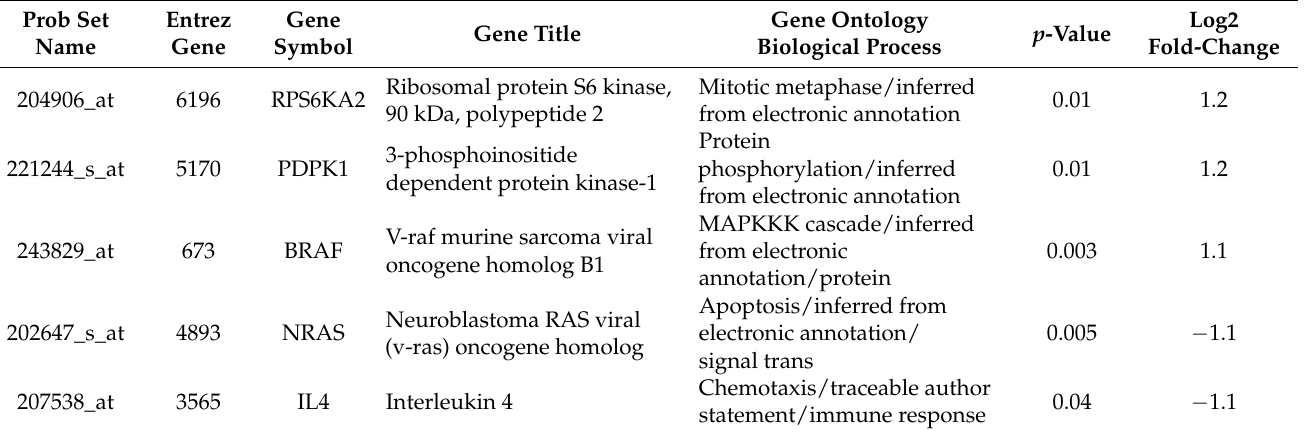
Table 8. Differential expression based on fold change of 5 transcripts annotated to genes that are involved the interleukin signalling pathway (Low magnesium